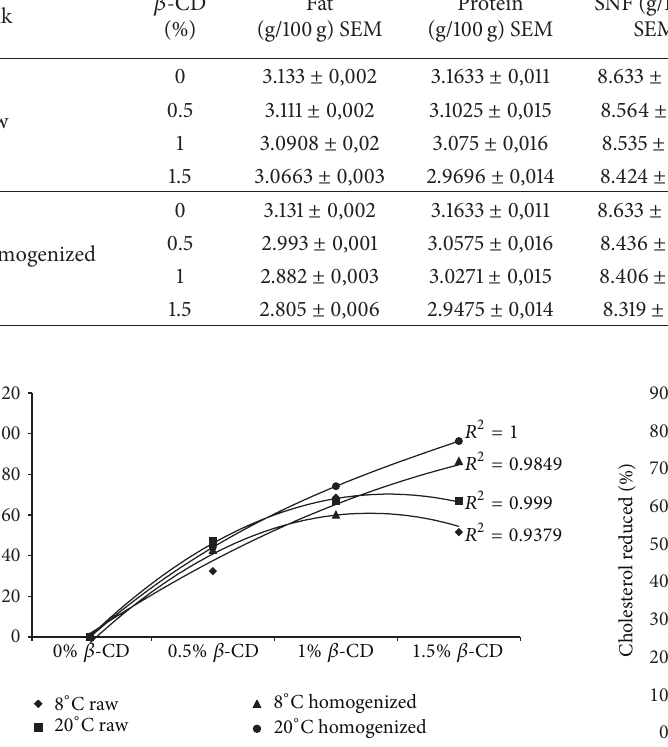
Table 2: Effect of various concentrations of 𝛽 -CD on main constituents and density of raw and homogenized milk. Milk